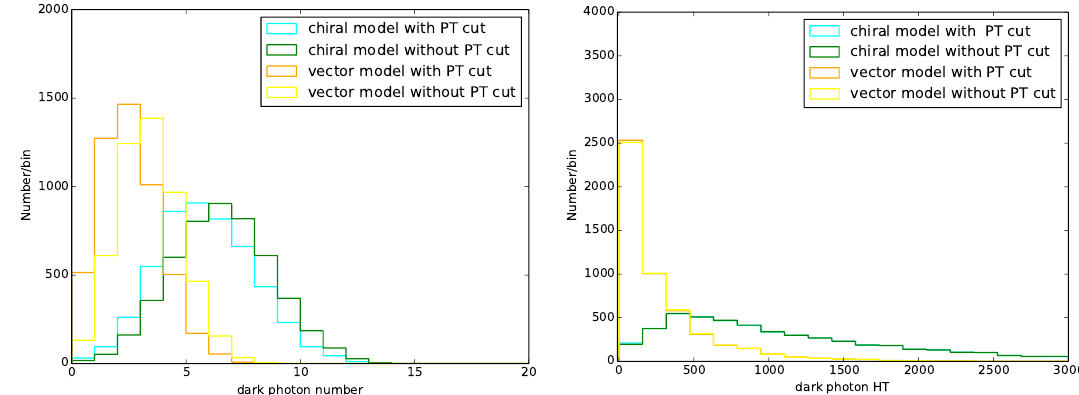
Figure 6 . Distributions of dark photons without a cut and with a cut p T > 10 GeV for the Vector Model and the Chiral Model. The parameters are set to Point C.